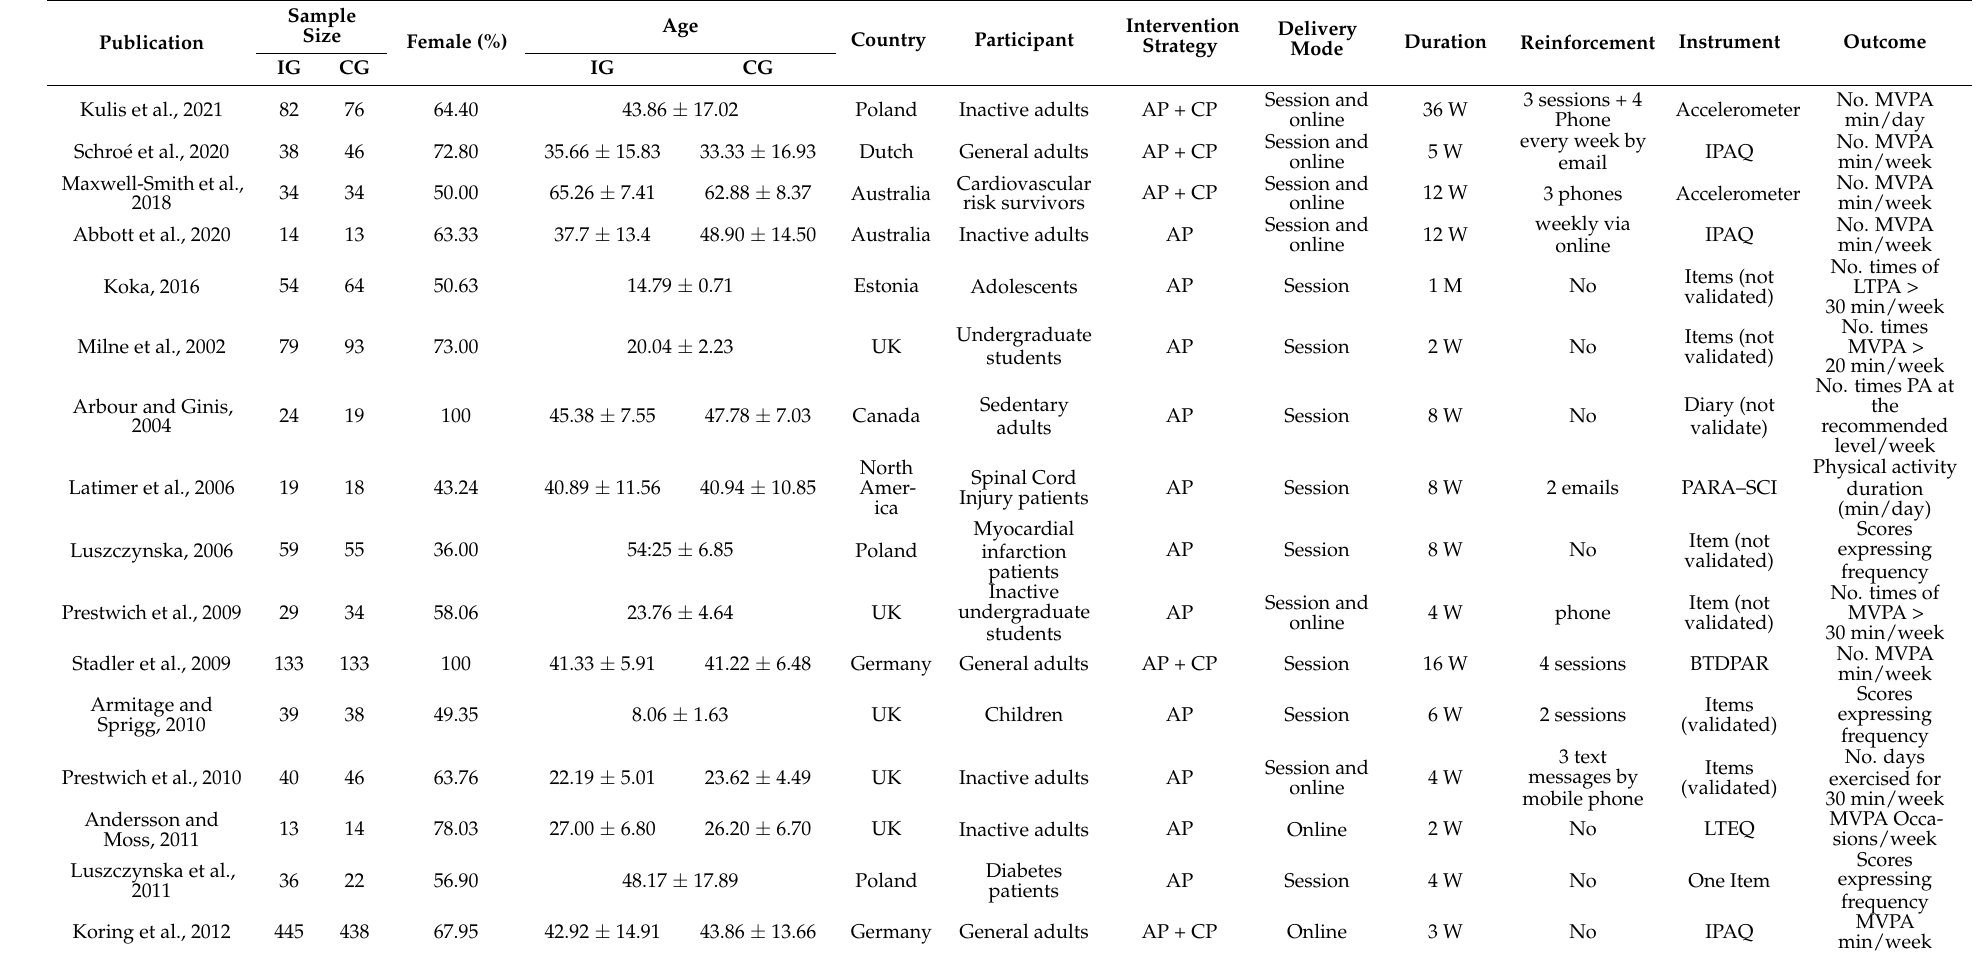
Table 1. Characteristics of